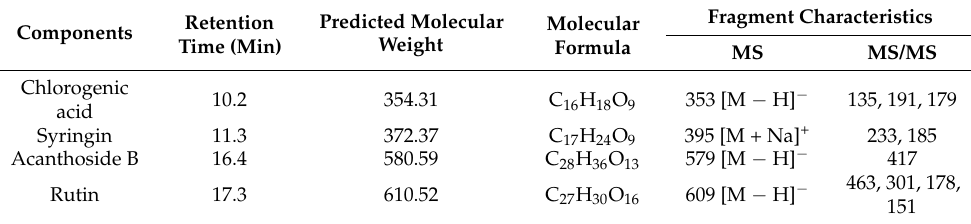
Table 1. Characteristics of main components of Saussurea involucrata by LC/MS n